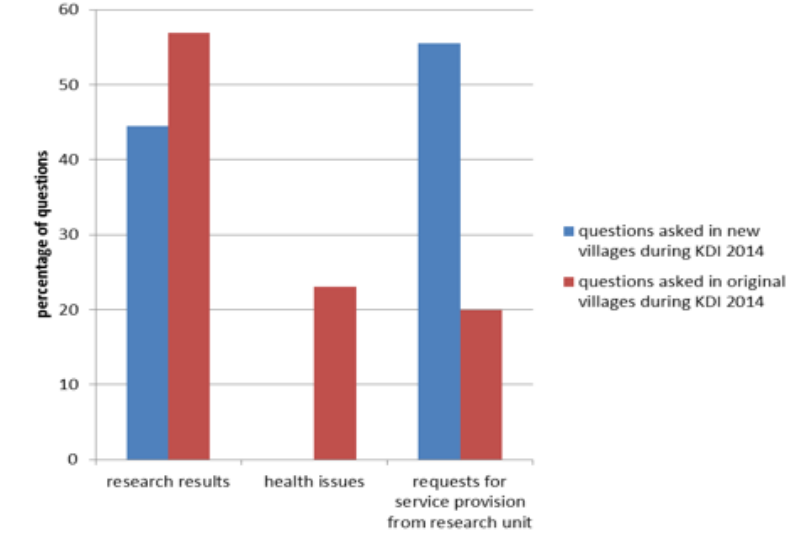
Figure 5: Questions